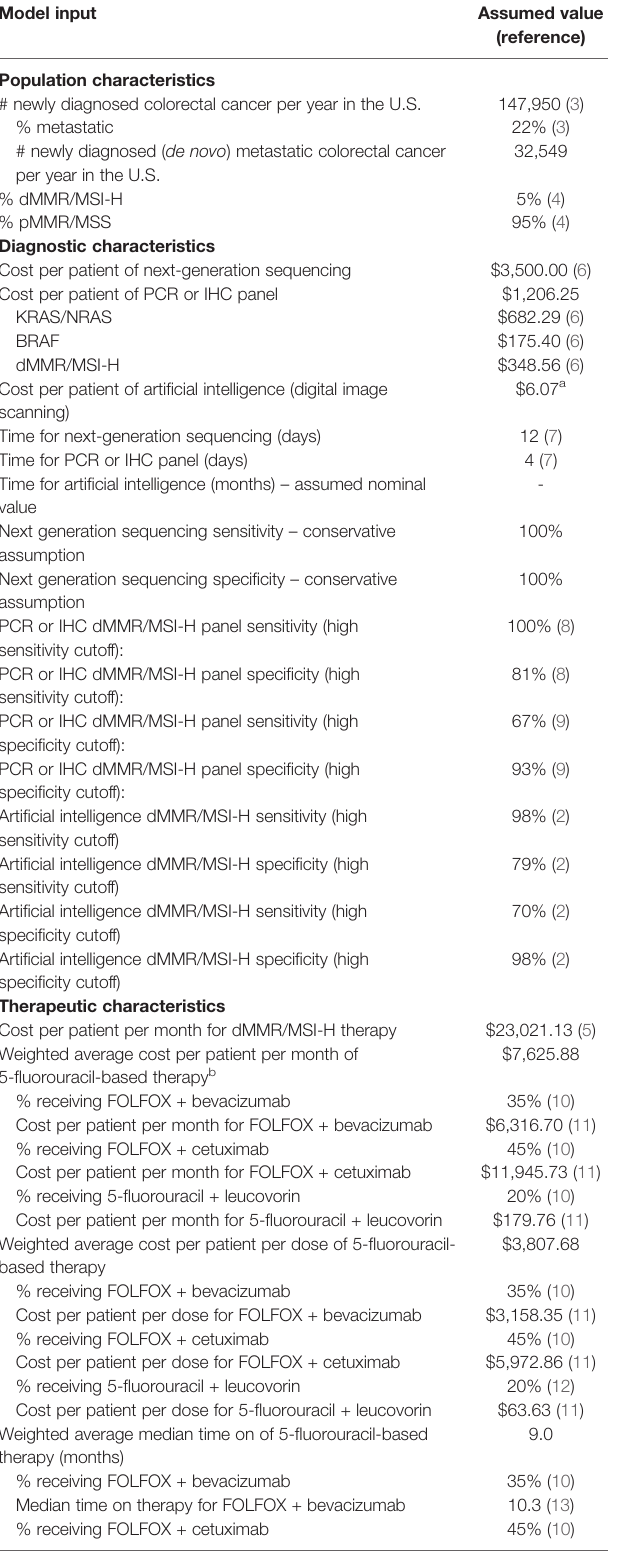
TABLE 1 | Model assumptions and inputs.